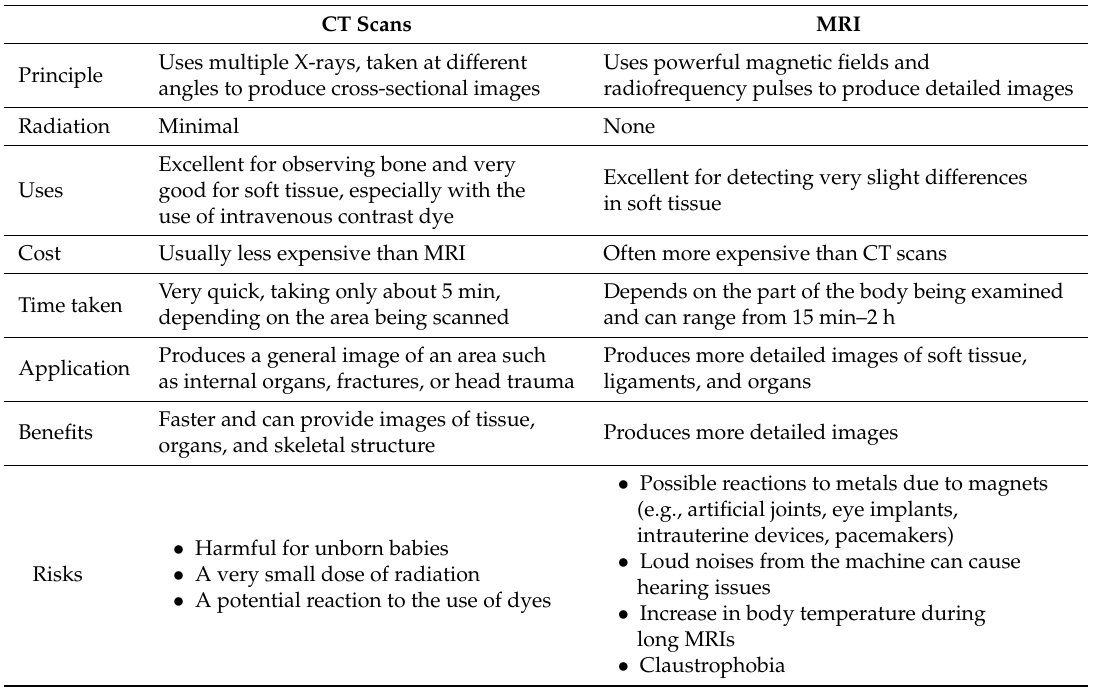
Table 1. Comparison between CT scans and